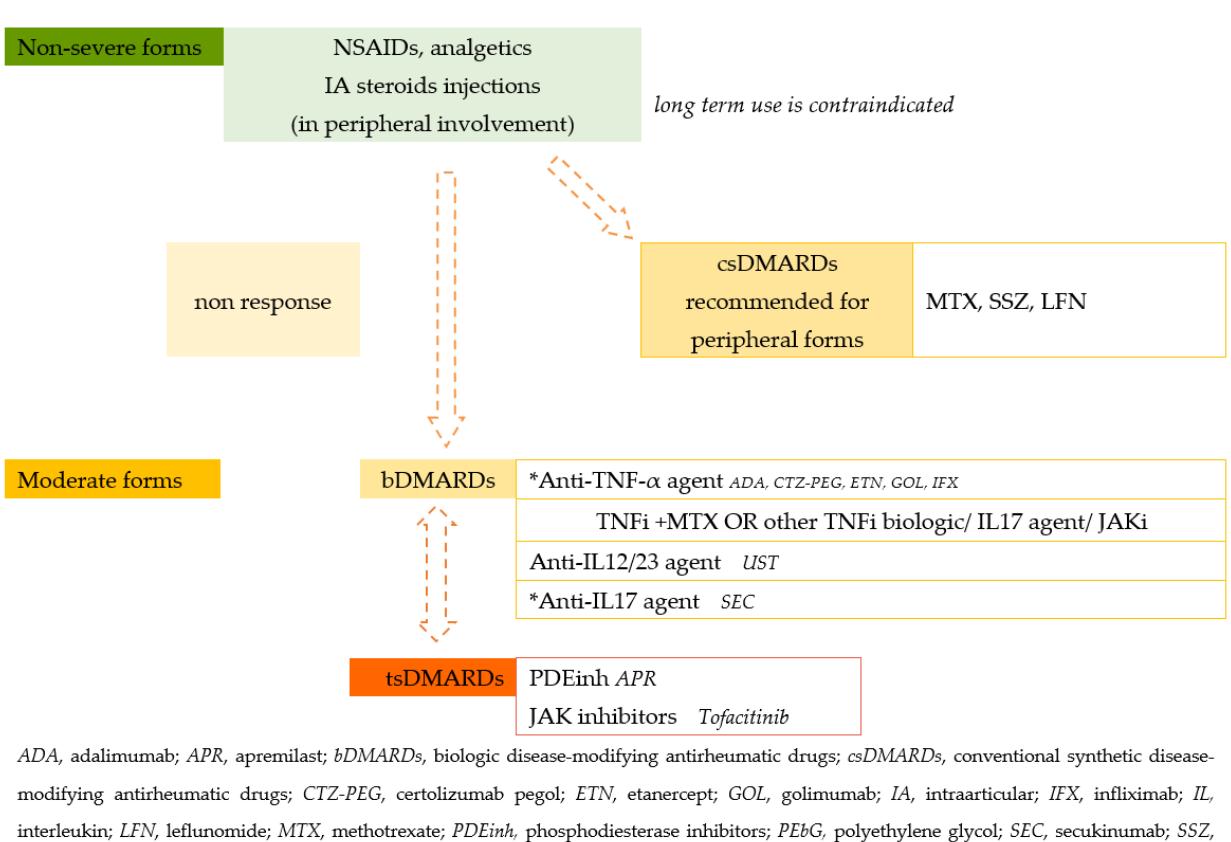
Figure 2. Treatment guidelines for PsA.